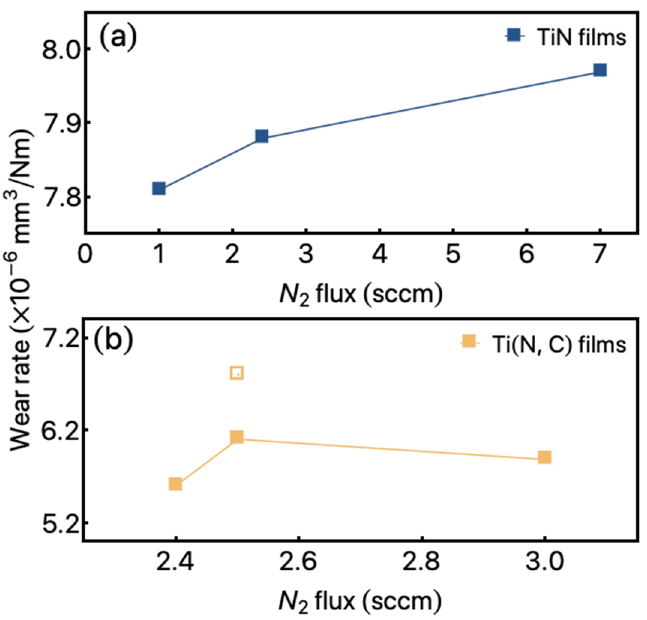
Figure 5. Wear rate as a function of N 2 gas flow for the studied films. ( a ) Results obtained from TiN films. ( b ) Results observed for the Ti(N, C) films with 66 mm 2 (close squares) and 132 mm 2 (open square) of carbon pallets.